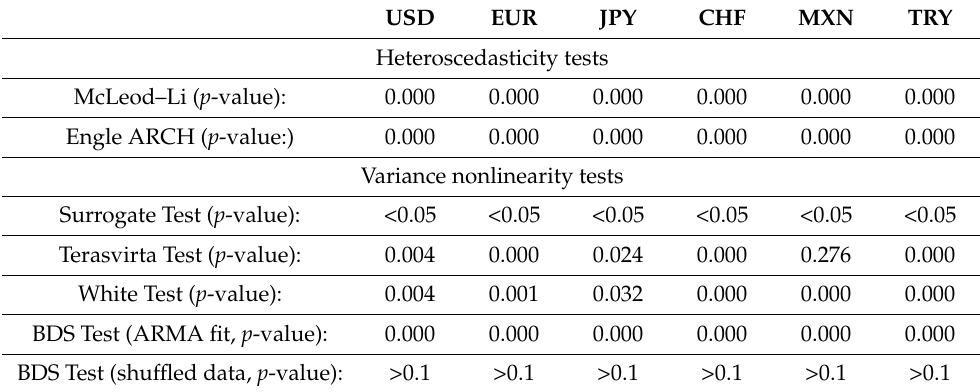
Table 4. Summary of the time-dependence and non-linearity analysis of the daily volatility time